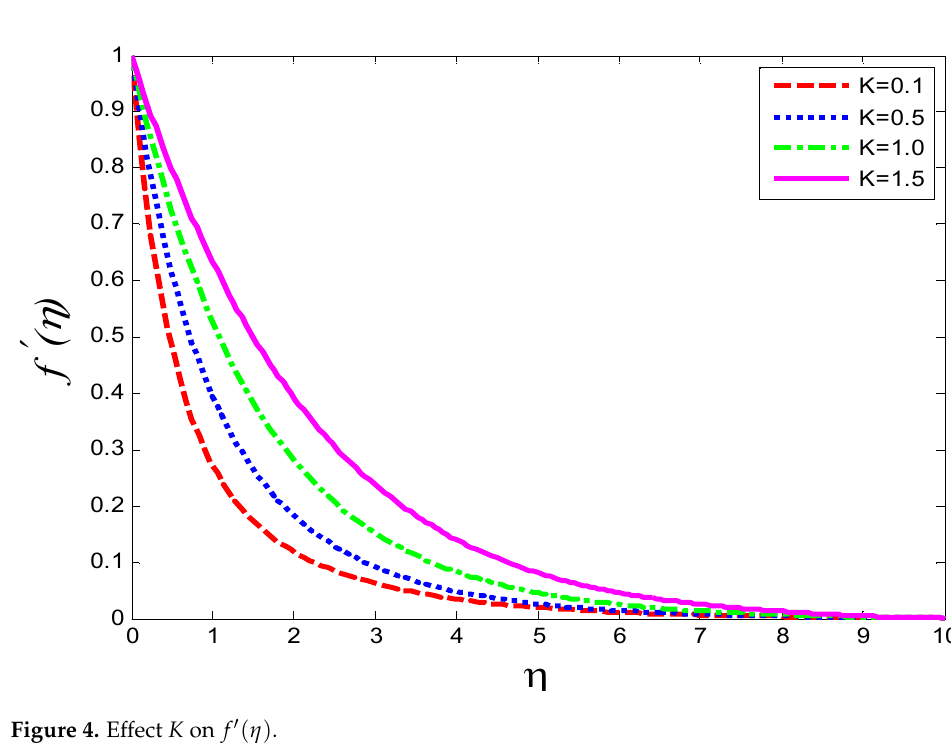
Figure 4. Effect 𝐾 on 𝑓 (cid:4593) (cid:4666)𝜂(cid:4667) . Figure 4. Effect K on f (cid:48) ( η )